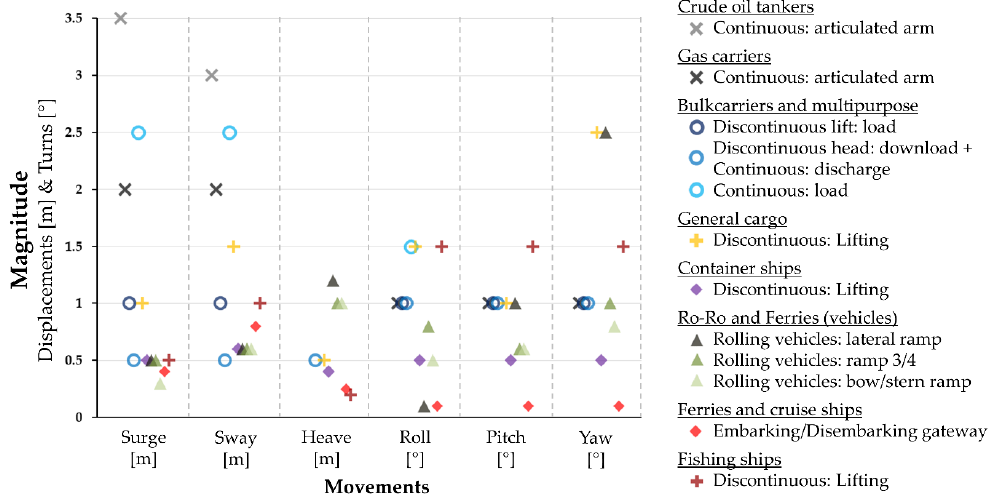
Figure 4. Review of operational thresholds for different ship types, considering the handling mean’s system. Own elaboration, based on the thresholds from ROM 2.0 (2011) [18].